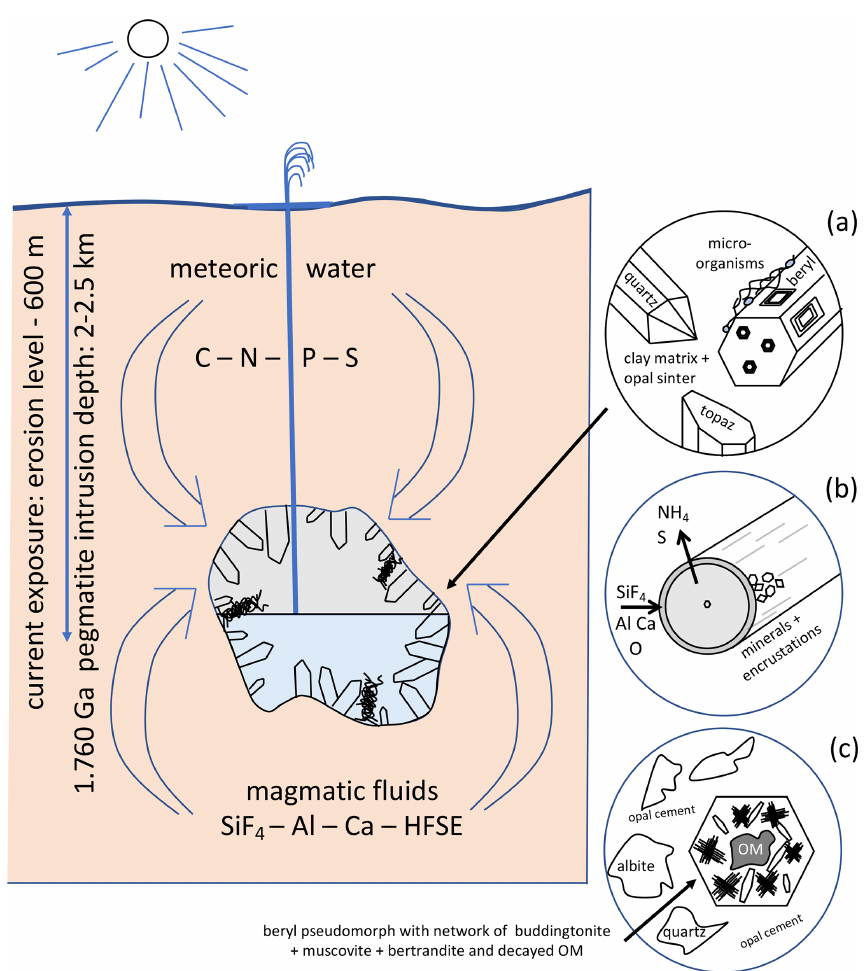
Figure 15. Schematic illustration of the geological environment of pegmatites of the Korosten pluton, Ukraine, with meter-sized miarolitic chambers and a near-surface geyser system. The chambers provided the space for an endolithic micro-ecosystem, which consists (a) of or- ganisms with three morphologically different types (filamentous, flaky, and rare spherical), attached to the pegmatitic minerals, also in etch pits of beryl. (b) Fossilization occurs due to influx of hydrothermal fluids carrying SiF 4 , Al, Ca, and high-field-strength elements (HFSEs) and starts with a micrometer-thin layer of Al–Si enrichment, which develops into clay minerals, feldspar, and finally into encrustations. (c) Strongly degraded OM is found also in breccias, formed during collapse of some chambers, providing NH 4 for the formation of budding- tonite, together with muscovite and bertrandite, in pseudomorphs after